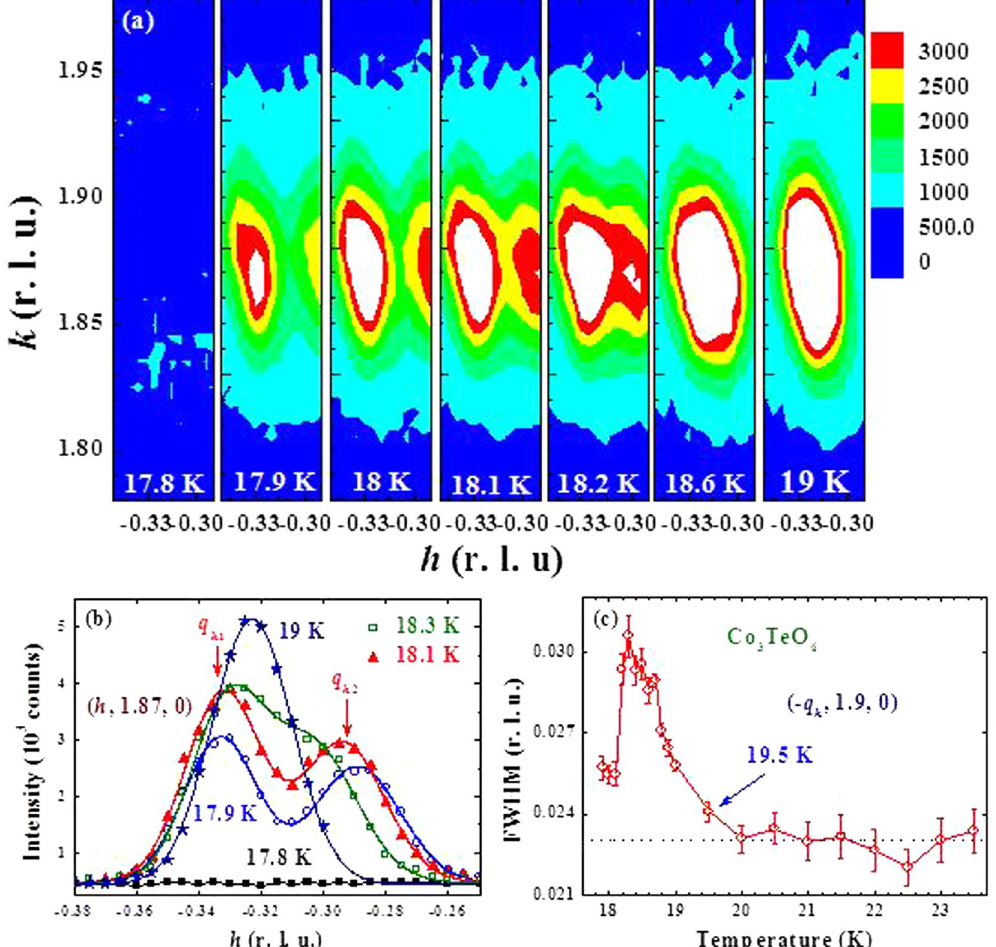
Figure 10. ( a ) Thermal variations of the intensity maps of the (020) − satellite magnetic reflection, covering 17.8 to 19 K. Splitting of the satellite reflection in the h direction is clearly seen on cooling below 18.2 K. ( b ) Diffraction peak profiles of the satellite (020) − reflection taken along the h direction at five representative temperatures, revealing the splitting of the reflection. ( c ) Temperature dependence of the full-width-at-half- maximum (FWHM) of one of the satellite reflection around